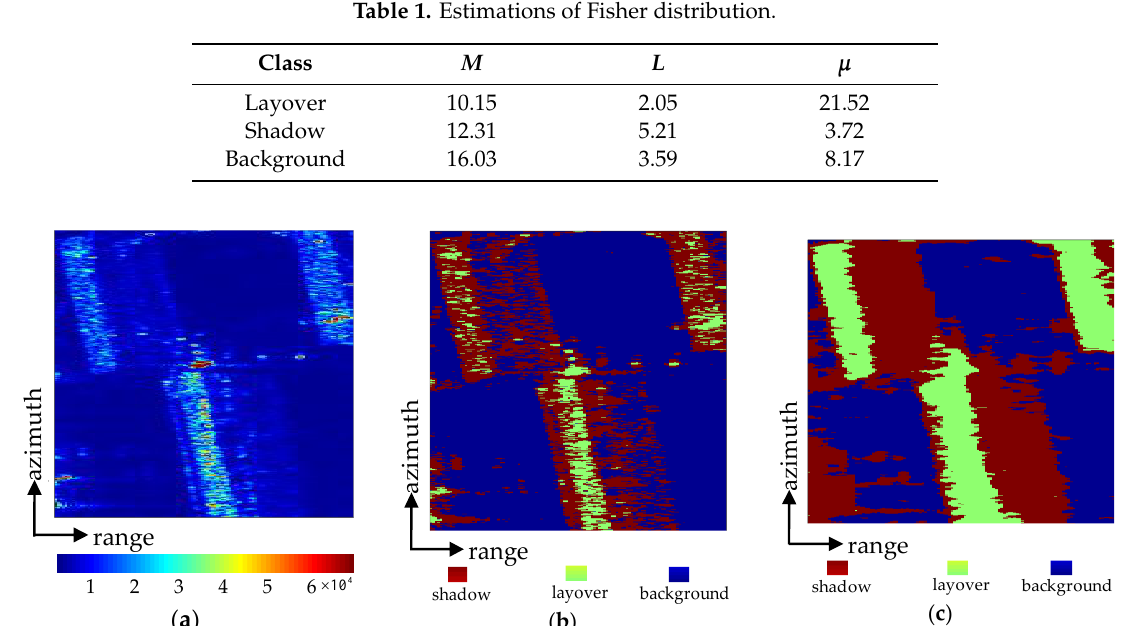
Figure 8. ( a ) The buildings in interferometric synthetic aperture radar (InSAR) amplitude image, and ( b , c ) the segmentation results based on traditional Markov random field (MRF) and coherent Markov random field (CMRF), respectively.